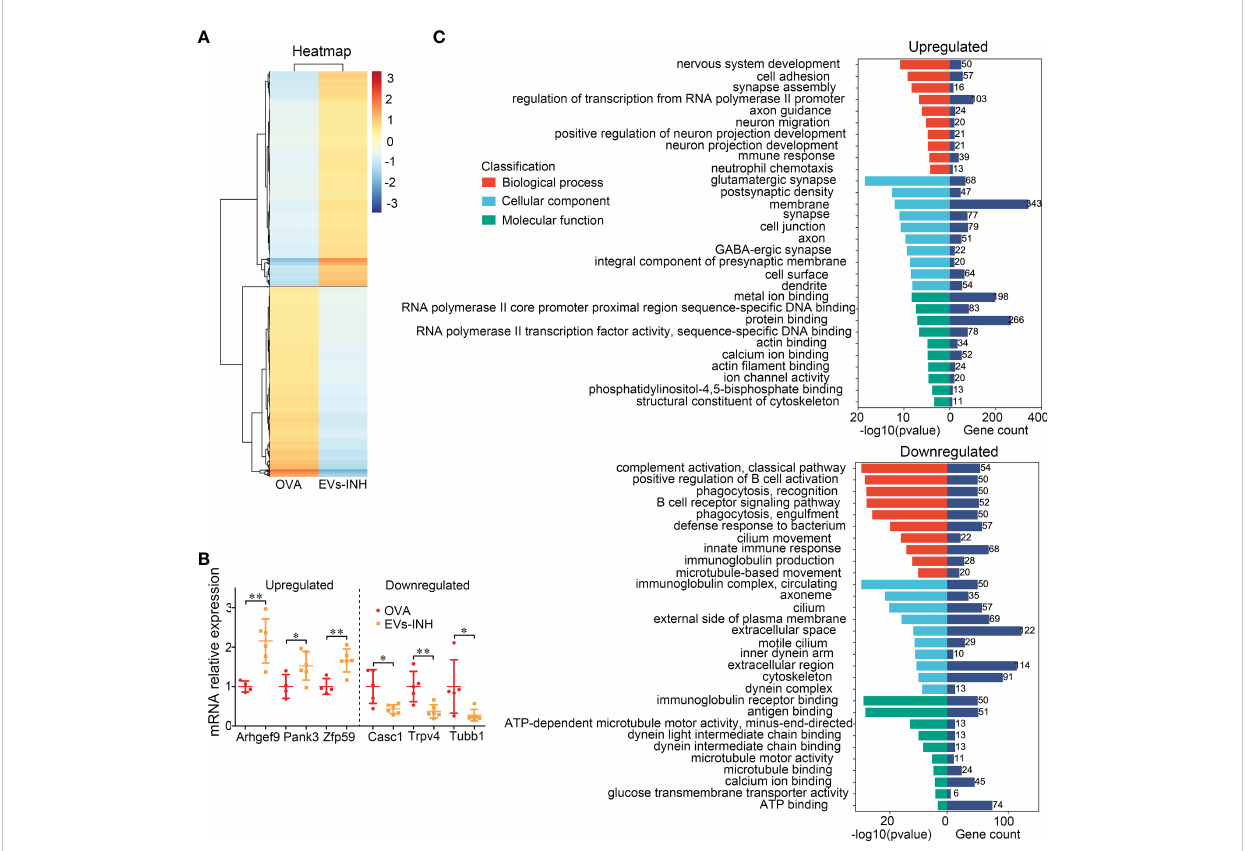
FIGURE 6 The differential expressed (DE) mRNAs in lungs between EVs-INH-treated mice and OVA-induced asthma mice. (A) Heat-map was constructed for DE miRNAs in EVs-INH vs OVA. (B) Real-time PCR veri fi cation of several of the lowlist differentially expressed genes. (C) GO analysis of the differentially up and down expressed genes in lungs between EVs-INH-treated mice and OVA-induced asthma mice. The top-ten statistically signi fifi cant results identi fifi ed including biological process (BP), cellular component (CC), and molecular function (MF) are listed. Each dot represents data from one animal and n = 4-6 per group. Student ’ s t-test: * P < 0.05, ** P <